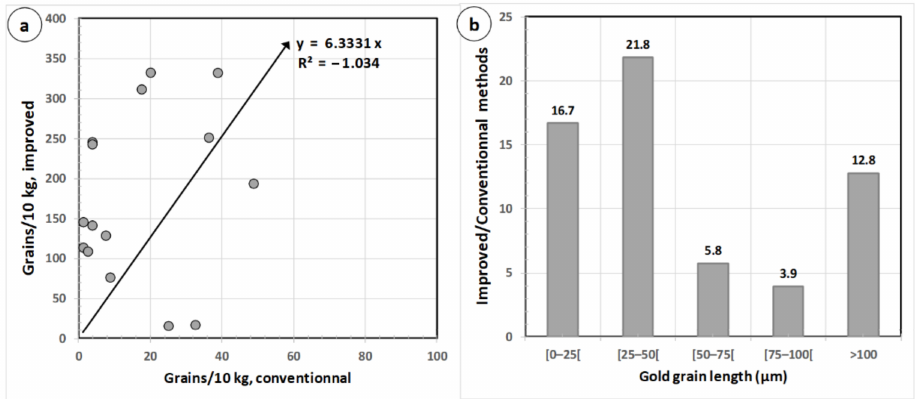
Figure 11. ( a ) Comparison of the conventional and improved methods in gold grain counts per sample for 15 paired samples. ( b ) Comparison of the ratio of the number of grains per 10 kg for the improved versus the conventional methods, according to grain size